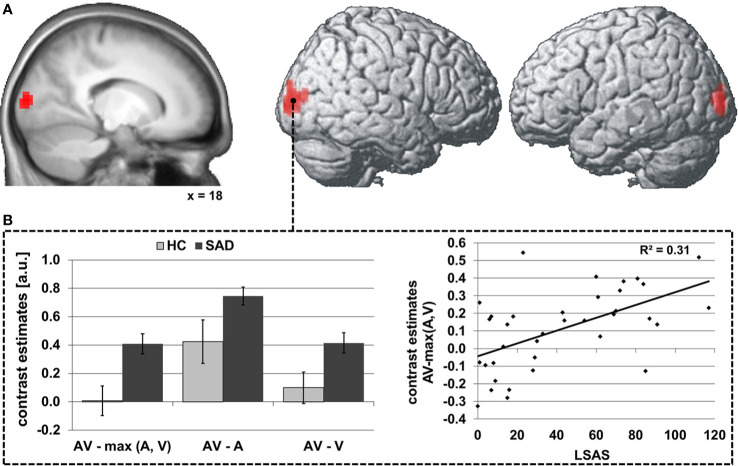
Differences in audiovisual face-voice-integration-related modulations of right STS FC between SAD and HC rendered onto the lateral aspects of a standard brain as well as a sagittal slice of the whole sample mean anatomy (psychophysiological interaction analysis; seed region as depicted in Figure 1) (A). Results shown at p < 0.05, cluster-size FWE-corrected for multiple comparisons across the whole brain at a voxel-wise threshold of p < 0.001. Coordinates refer to the MNI system. Voxel size 3 x 3 x 3 mm3. The diagrams (B) illustrate the underlying differences in FC between audiovisual (AV), auditory (A) and visual (V) stimulation (left) as well as the correlation of the face-voice-integration effect with individual SA severity (LSAS, right). Light columns refer to HC and dark columns to SAD. Error bars indicate the standard error of the mean.